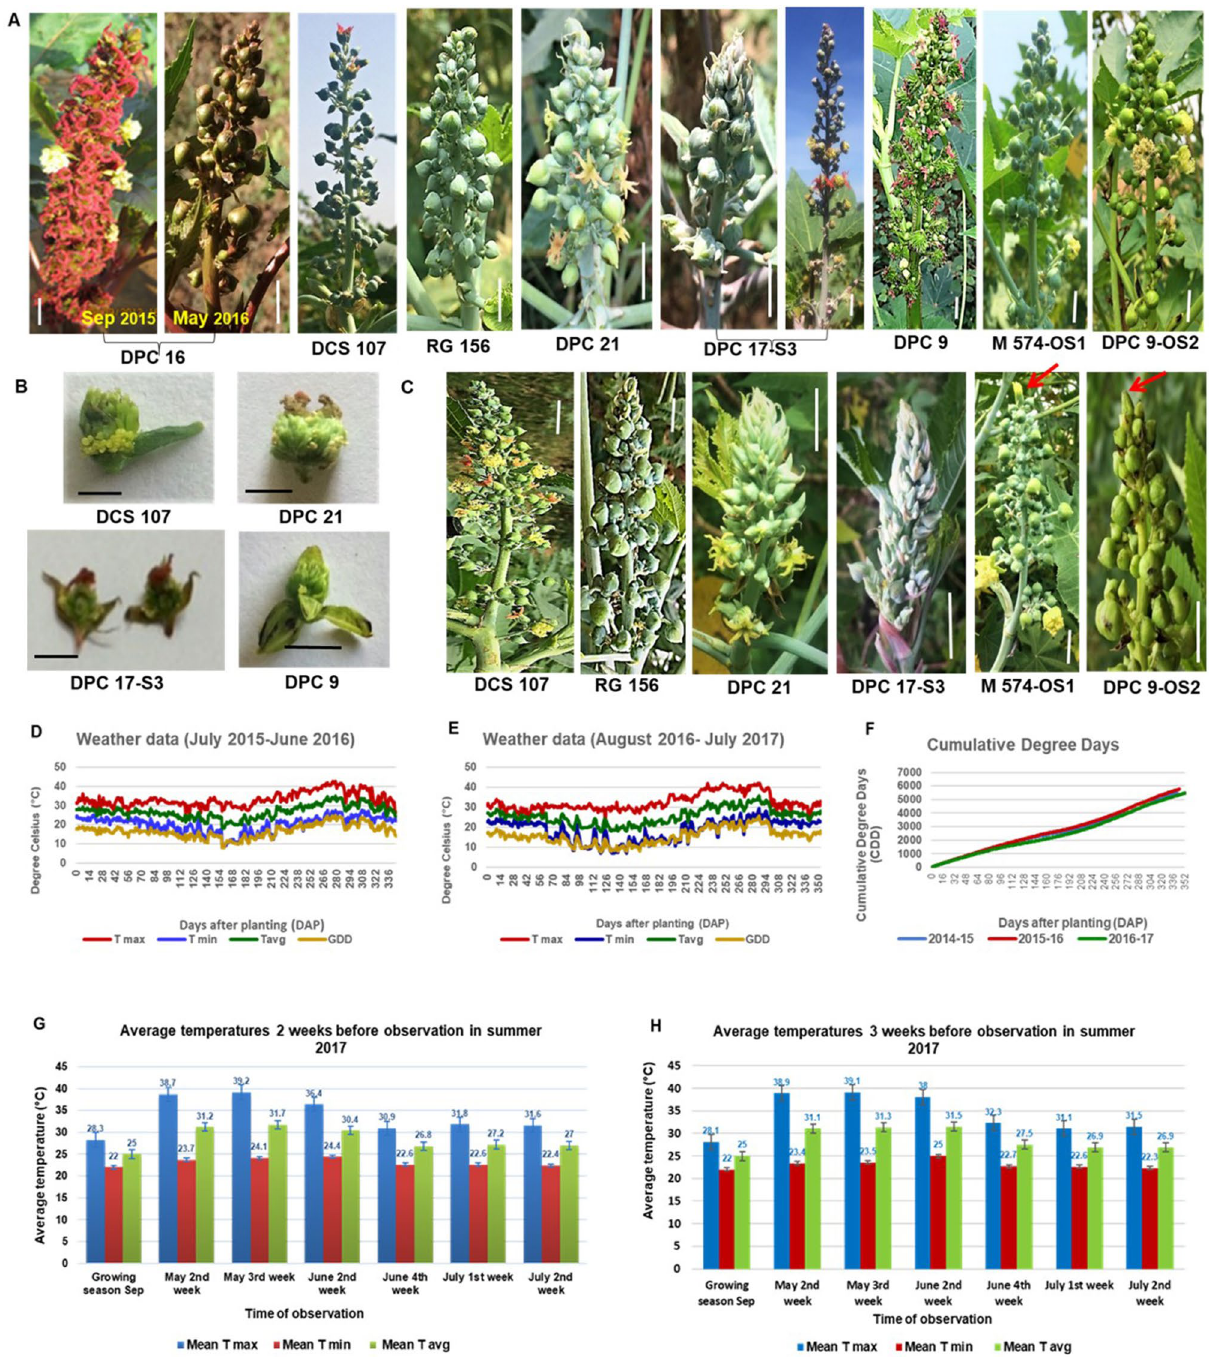
Figure 7. Sex expression in castor in response to temperature. ( A ) Alteration of sex phenotypes towards completely or predominantly male spikes in castor genotypes at high temperatures during summer in March -May (T max 39–42 °C). ( B ) Bisexual flowers in castor genotypes in summer ( C ) Restoration of normal phenotype in June-July at normal temperatures (T max 28–33 °C). Genotype names are indicated below. Arrows indicate terminal female flower. Weather data during growing seasons ( D ) 2015–16 and ( E ) 2016–17. ( F ) Cumulative degree days during 3 growing seasons 2014–15, 2015–16 and 2016–17. Temperature parameters (mean of T max , T min and T avg ) existing for ( G ) 2 weeks and ( F ) 3 weeks before observation of altered sex phenotype in inflorescences during summer. Scale bars: 1 cm are